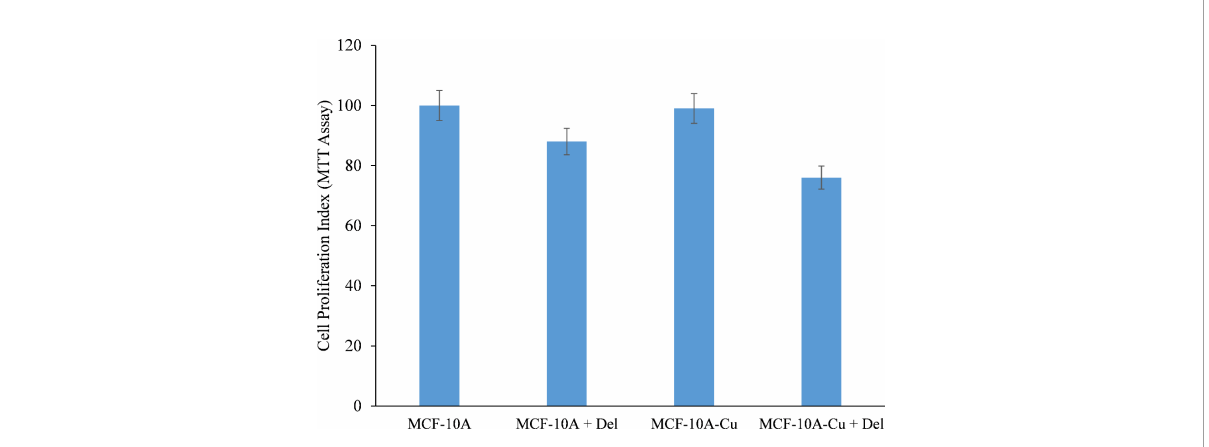
FIGURE 7 Effect of delphinidin on cell growth suppression in MCF-10A (normal breast epithelial cells) and MCF-10A cells cultivated in Cu (II)- supplemented medium (MCF-10A-Cu). MCF-10A and MCF-10A-Cu (normal cells cultivated in a medium containing 25 µM CuCl 2 ) were